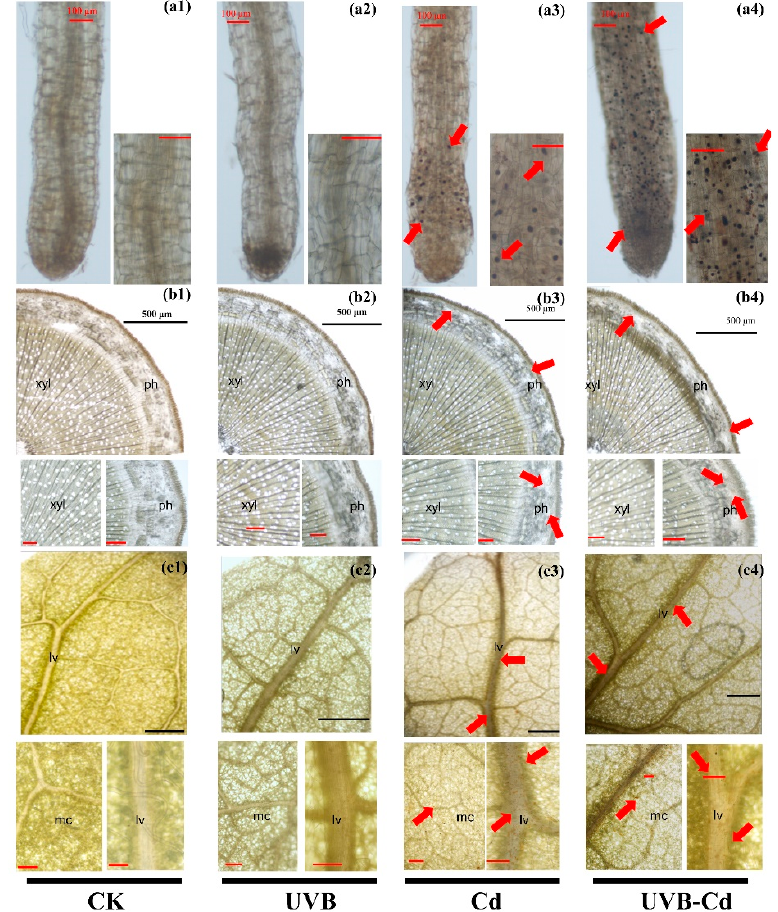
Figure 4. Cd localization and accumulation in roots ( a1 – a4 ), stems ( b1 – b4 ) and leaves ( c1 – c4 ) of poplar under different treatments. The red arrow indicates the precipitation of Cd-dithizone. Red bar scale = 100 μ m, black bar scale = 500 μ m. ph, phloem; xyl, xylem; lv, leaf vein; mc, mesophyll cells. The experiment was repeated at least three times, each time with similar results. A group of photographs was selected for display.